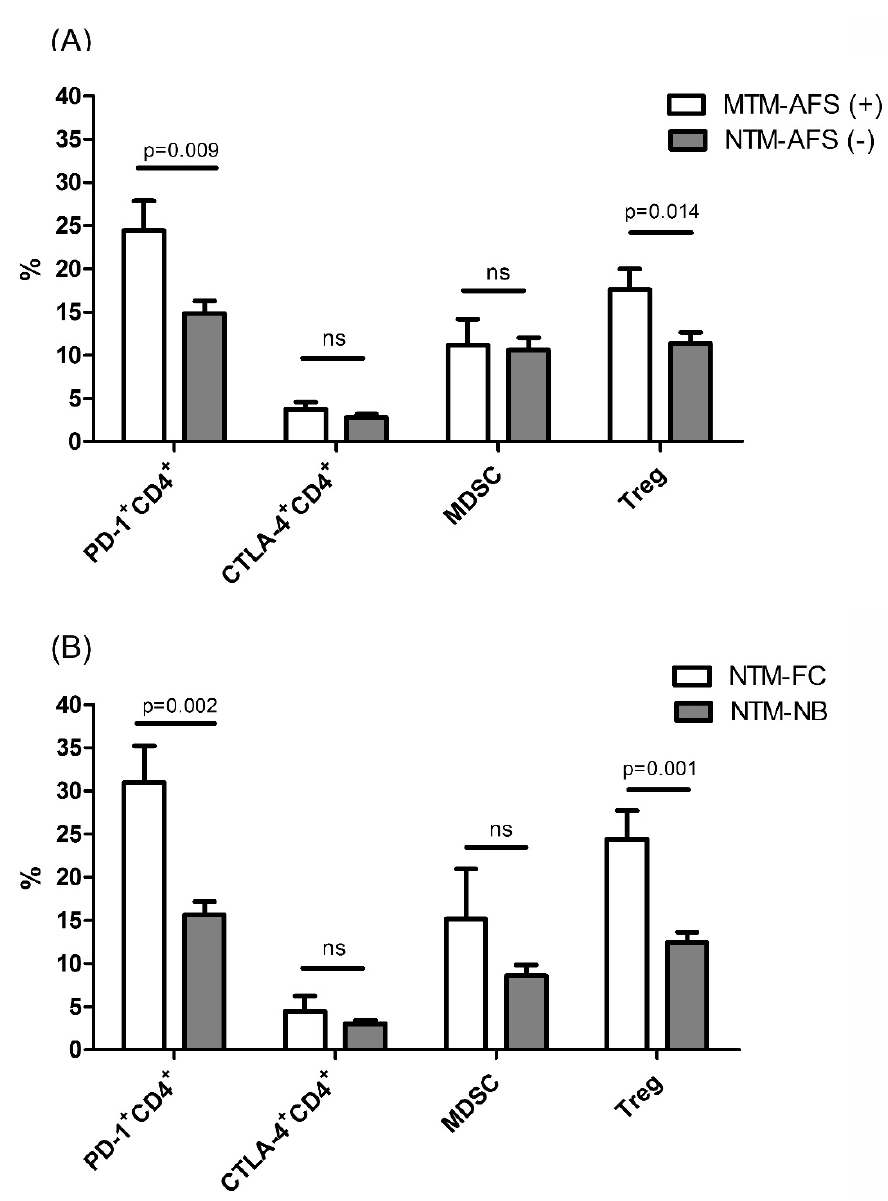
Figure 3. The percentages of regulatory T cells (Treg), programmed death-1 (PD-1) and cytotoxic T-lymphocyte antigen-4 (CTLA-4) on CD4 lymphocytes, and myeloid derived suppressor cells (MDSCs) among the patients with nontuberculous mycobacteria-lung disease (NTM-LD) according to ( A ) positive or negative acid-fast bacilli staining for sputum, and ( B ) initial radiographic findings. The data in the bar charts are mean values and error bars are standard errors. The data were compared using the Mann Whitney U test. Y axis means percentage in (1) lymphocyte population for Treg, PD-1 + CD4 + , and CTLA4 + CD4 + cells, and in (2) peripheral blood mononuclear cells for MDSCs. NTM-LD includes Mycobacterium avium complex and M. abscessus lung disease. FC, fibro-cavitary; NB, nodular bronchiectasis. ns, not statistically significant ( p > 0.05)